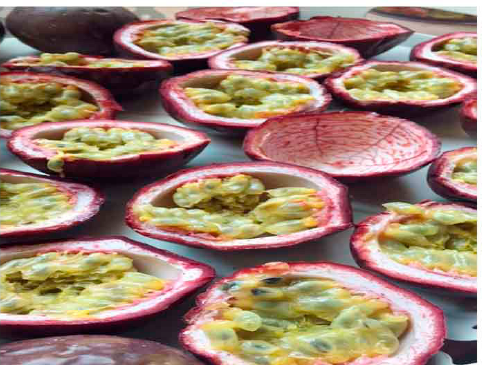
Fig. 1. Passion fruit ( Passiflora edulis f.